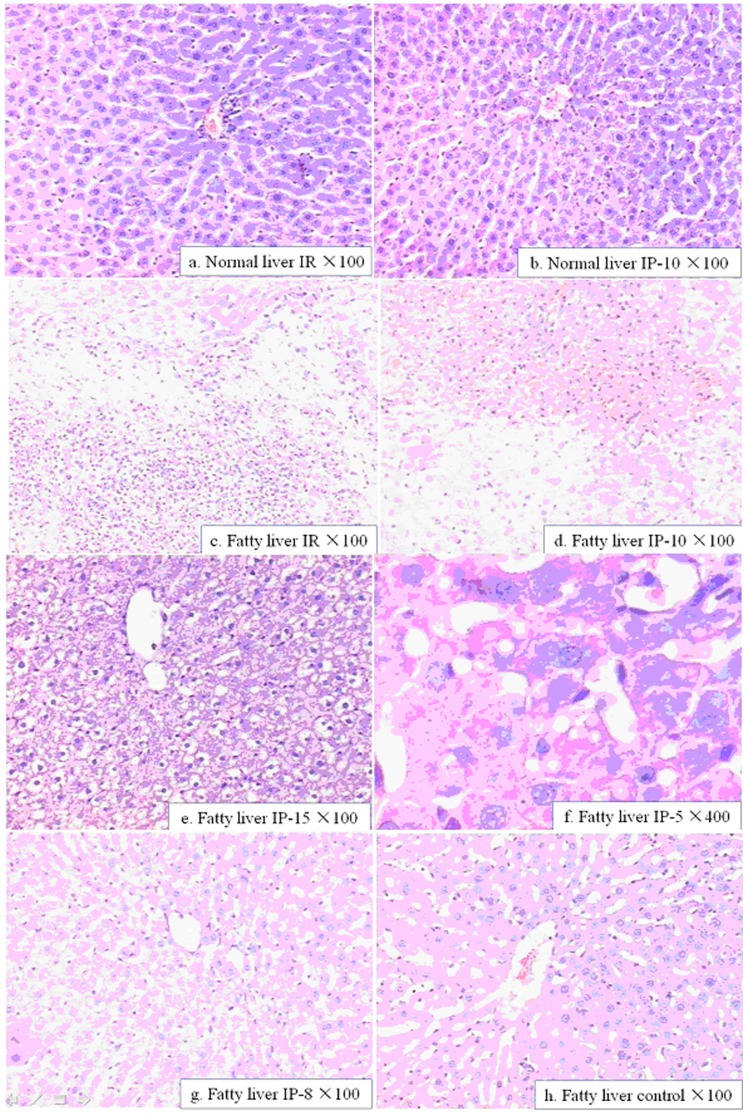
Histological lesions in liver at 24 hours of hepatic reperfusion.(a) I/R(normal): small area of hepatocyte necrosis and coagulative necrosis with neutrophil infiltration. (b) IP-10(normal): slight incipient and coagulative patchy necrosis of isolated hepatocytes. (c) I/R(fatty): extensive and confluent areas of coagulative necrosis, neutrophilic infiltration, and hemorrhage were observed. (d) IP-10(fatty): patchy areas of hepatocyte incipient necrosis and scattered multifocal areas of coagulative necrosis with neutrophil infiltration were observed, similar to (e) IP-15 (fatty). (f) IP-5(fatty) (original magnification ×400): irregular area of hepatocyte incipient necrosis with neutrophil infiltration, similar to (g) IP-8(fatty), the percentage of necrosis was significantly less in preconditioned than in unpreconditioned group. (h) fatty liver: severe fatty infiltration in hepatocytes as contrl. Hematoxylin-eosin(HE) staining; original magnification ×100.